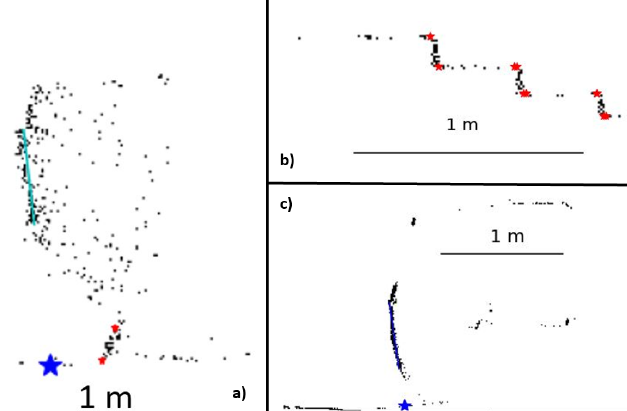
Figure 6: Examples of vectorization results. a) Bad vectorization for a brush generating 2 FP (curb and vertical object); b) Successful vectorization of staircase steps; c) FP generated by a car’s